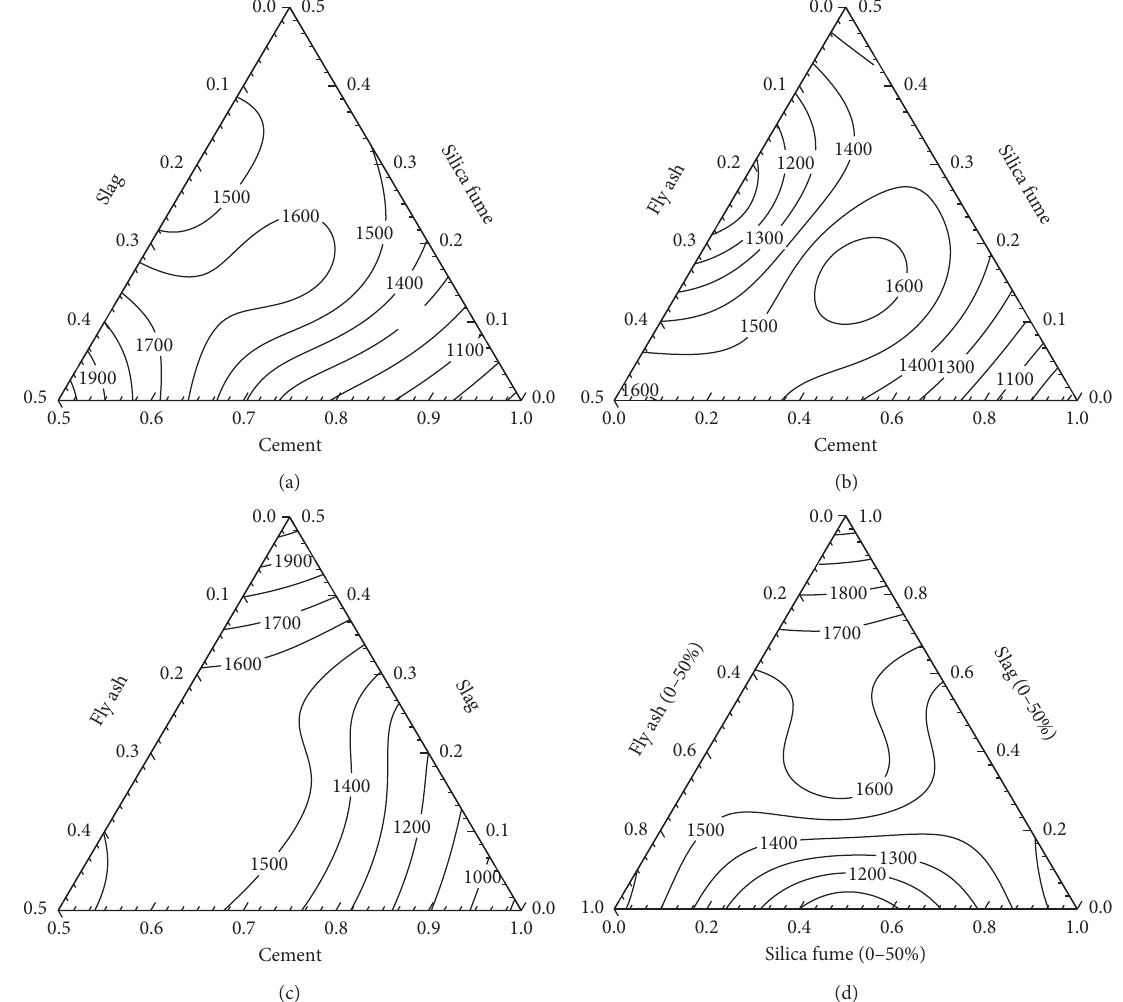
Figure 10: Autogenous shrinkage of UHPC (3d) with cementitious system of cement-silica fume-slag-fly ash (M-PCE).